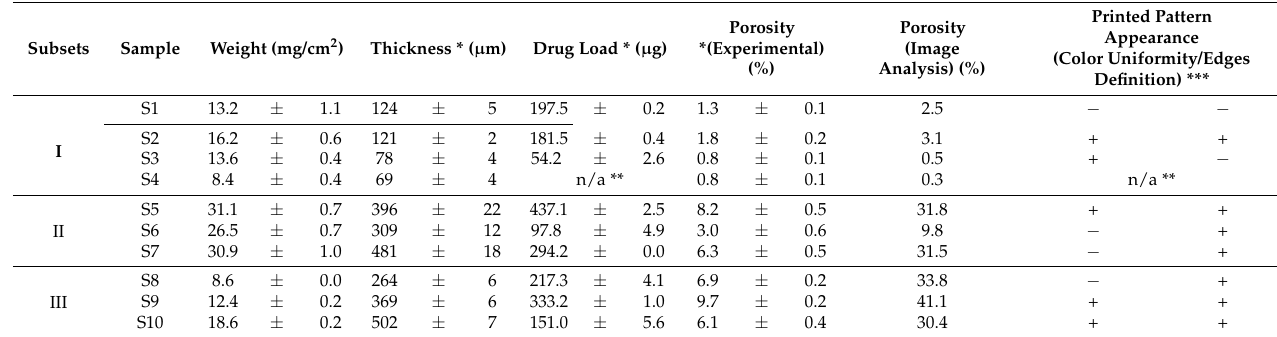
Table 2. Printing substrate